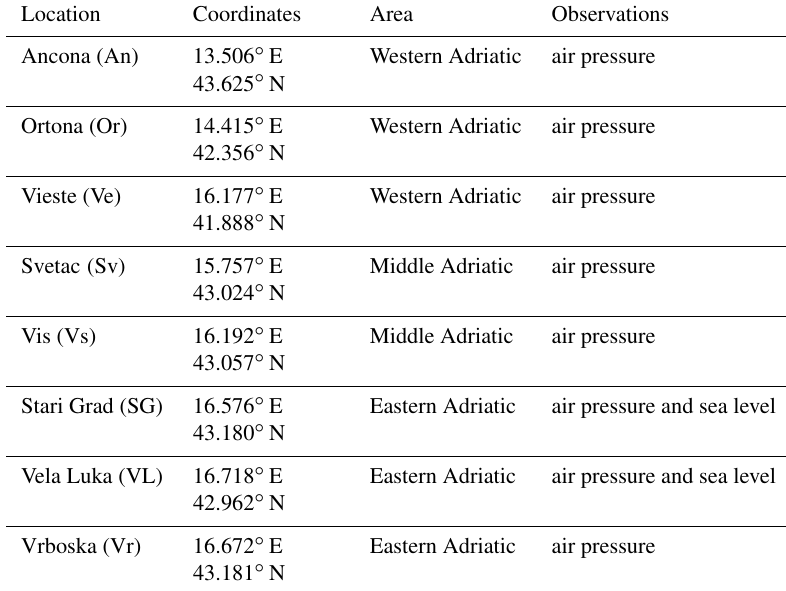
Table 1. Microbarograph and tide gauge locations.